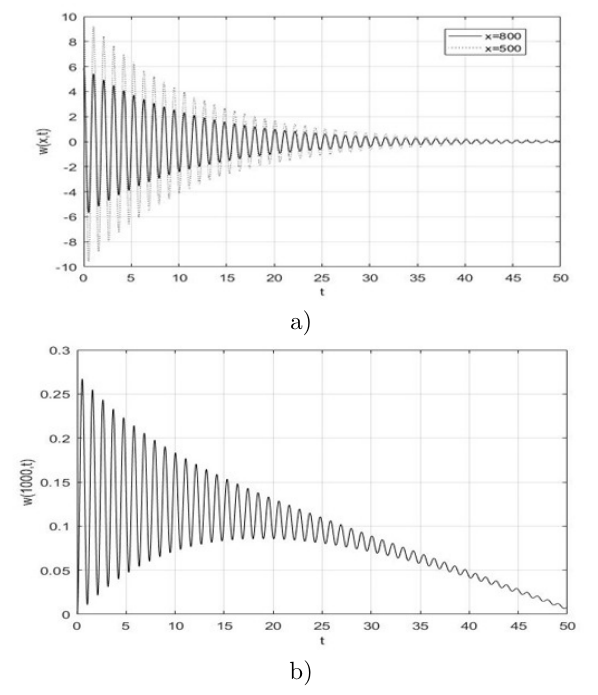
Figure 1. Riser displacement at a) x = 500 and x = 800, b) x =